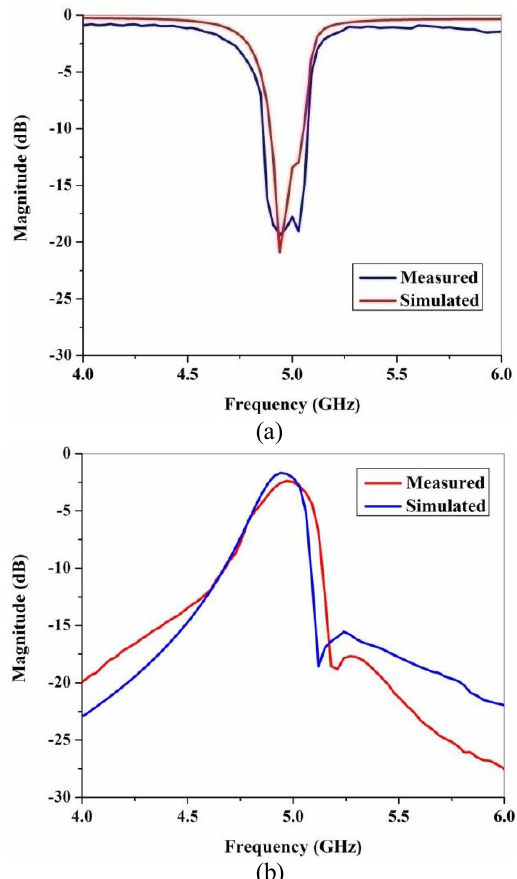
Figure 11: Simulated and measured results of bandpass filter using vertical slot (Filter B) (a) return loss, (b) insertion